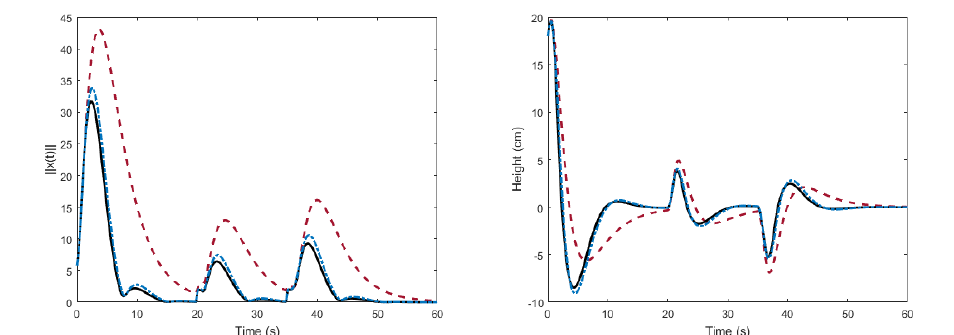
Figure 4. Norm of the state vector ( left ) and output response ( right ) of the linear model of the air levitation system. Solid black line: the proposed algorithm. Dot-dashed blue line: the algorithm in [30]. Dashed red line: auxiliary PI